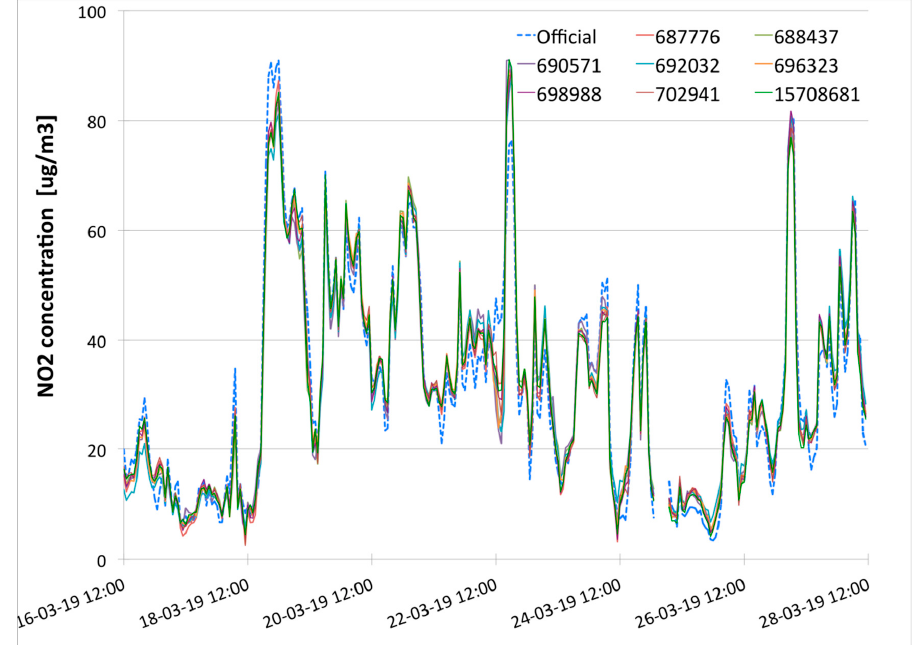
Figure 3. Result of a co-location experiment comparing a set of eight low-cost sensor systems measuring NO 2 with a reference instrument, between 3 March 2019 (MET) and 28 March 2019 (MET-DST). The labels of the curves in the figure indicate the results of the o ffi cial reference measurements and results of the